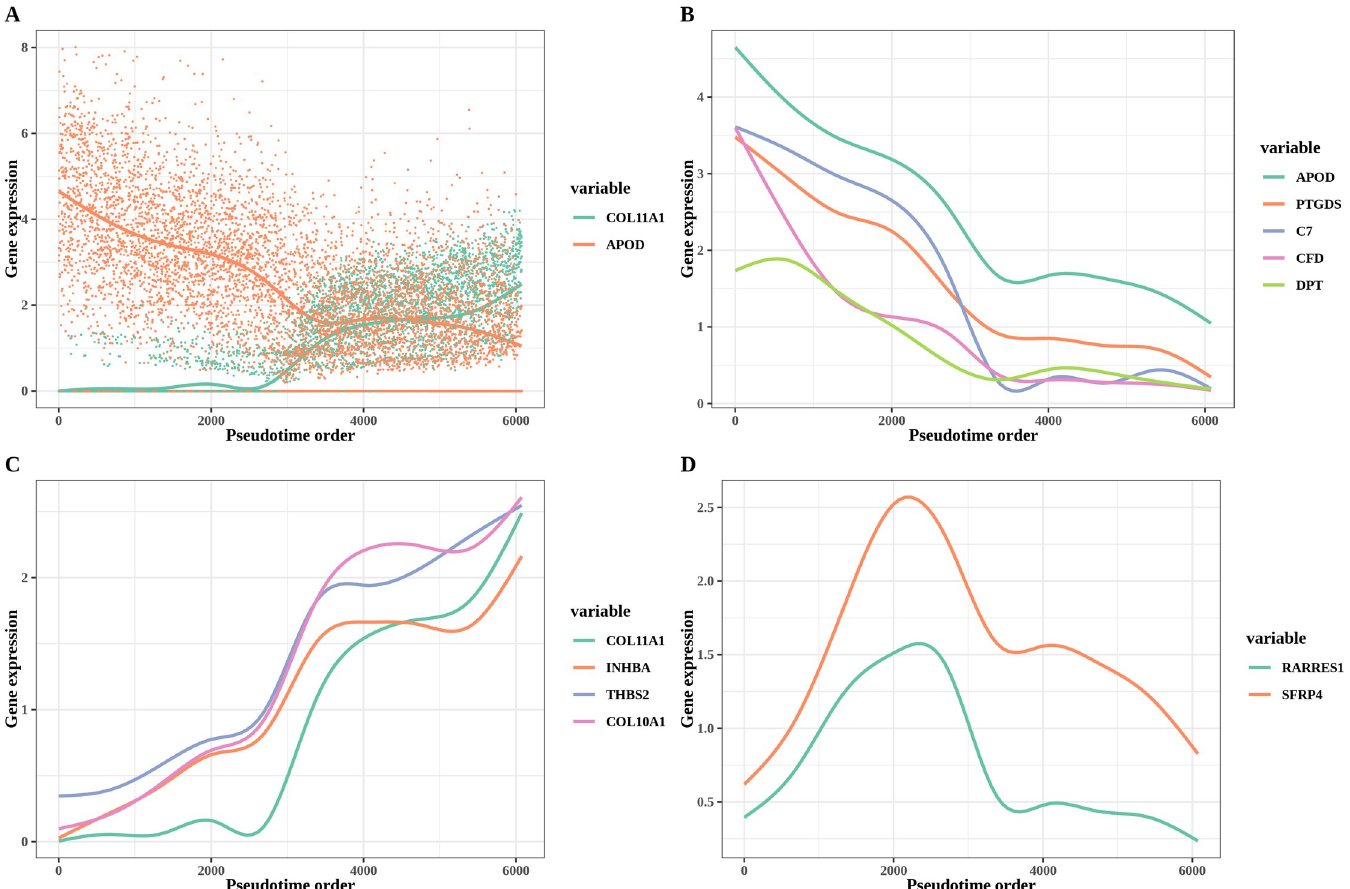
Fig 2. Trajectory analysis of PDAC. A. GAM fit to pseudotime ordered expression data to visualize the trend of gene expressions. B. Expression of adipose-related genes along the transition lineage. The x axis shows the cell orders and the y axis shows the normalized read count. C. Expression of COL11A1 -associated genes along the transition lineage. D. Expression of RARRES1 and SFRP4 genes along the transition